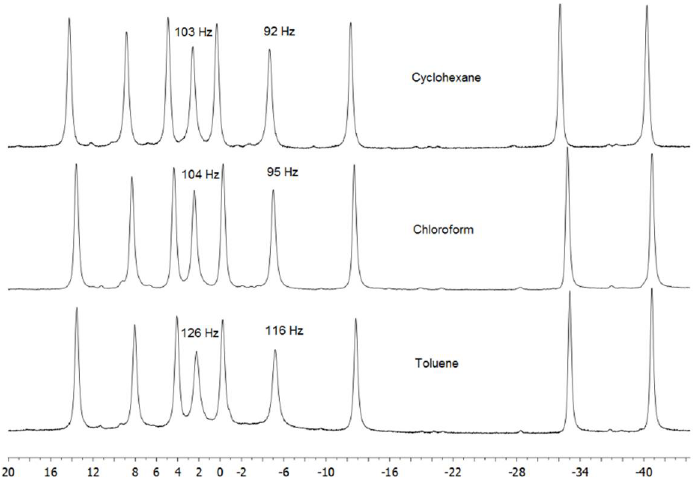
Figure 3. The crystal structure of the anti -B 18 H 22 —benzene solvate [28] with anti -B 18 H 22 ···benzene stacks arising from interaction between the H(8,9) bridging hydrogen atom and the π-cloud of the benzene ring.